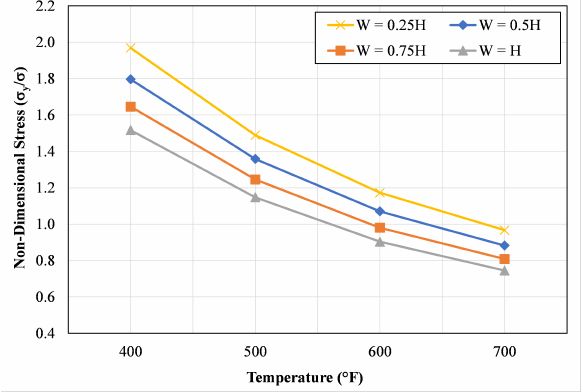
Figure 10: Relationship between σ y / σ on the expansion loop pipe 20-inch diameter with increasing temperature.